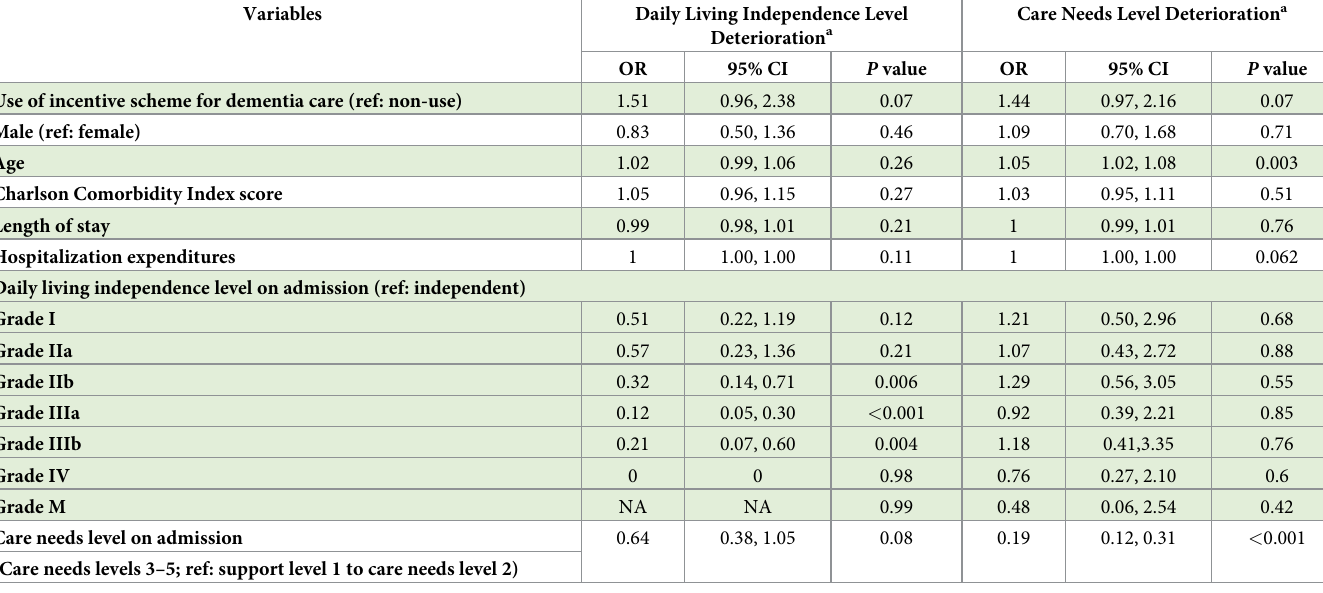
Table 4. Multivariable logistic regression analyses of deterioration in care needs levels and daily living independence levels at one year after discharge.